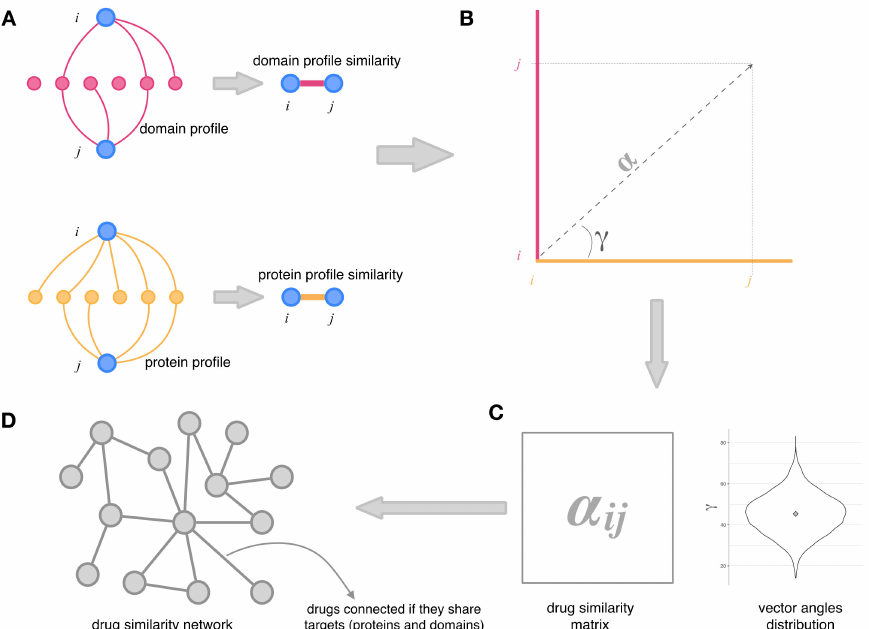
Figure 1. Integration of domain and protein data in a drug similarity network. ( A ) Drugs i and j are associated if they target the same domains or the same proteins; ( B ) hypergeometric indices measuring the similarity of the domains profiles between i and j (pink) and the similarity of the protein profiles (yellow) are represented as a vector; ( C ) drug similarity matrix obtained from the modules ( α ) of the hypergeometric indices and distribution of the angles of the vectors obtained for all drug pairs; ( D ) the drug similarity network is built from the drug similarity matrix.